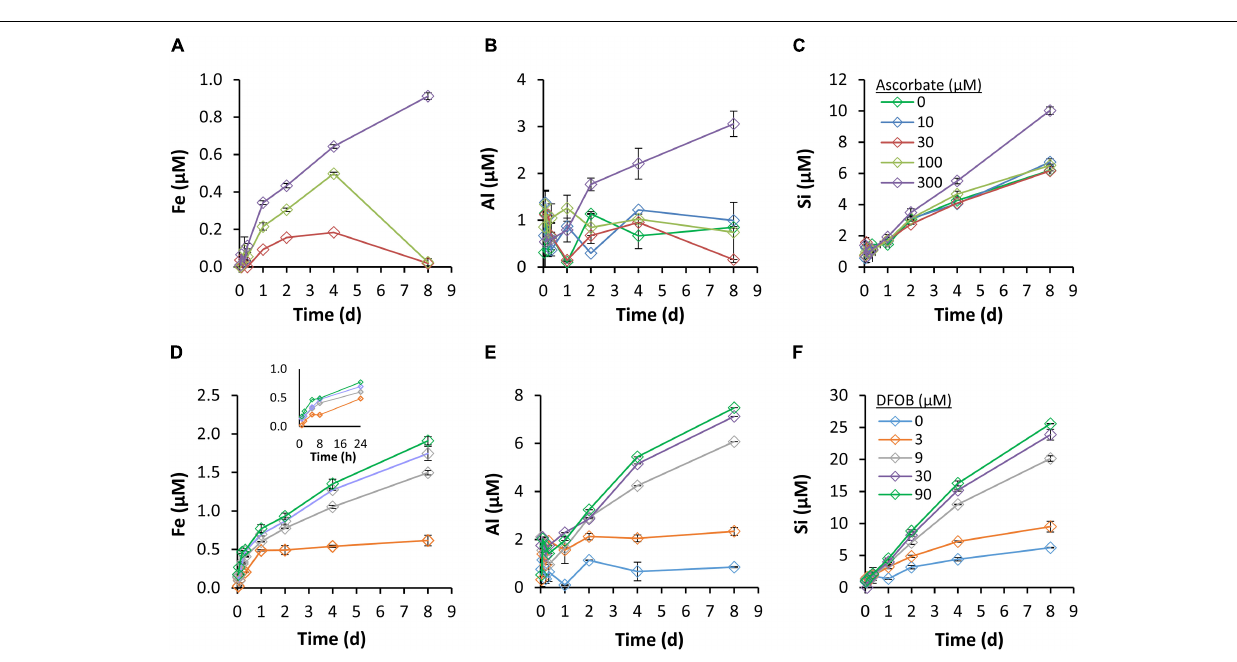
FIGURE 3 | Dissolution kinetics of Fe (A,D) , Al (B,E) , and Si (C,F) in the presence of ascorbate (A–C) and DFOB (D–F) . A 0.3 g dust L − 1 dust-SOW suspension was supplemented with 3–90 µ M of DFOB or 10–300 µ M of ascorbate and incubated with shaking. Dissolution was monitored over a period of 8 days; the solution phase was sampled at designated time points, filtered and analyzed by ICP-OES. Iron concentrations in the 0 µ M DFOB, and 0 and 10 µ M ascorbate treatments were below the detection